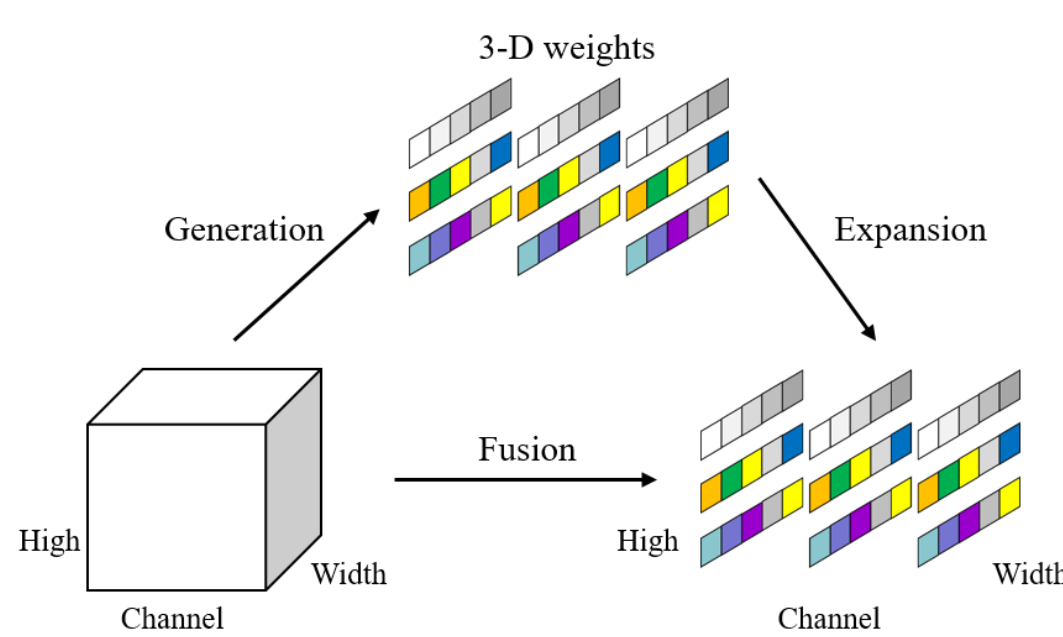
Figure 5. Principle of a simple and parameter-free attention module.